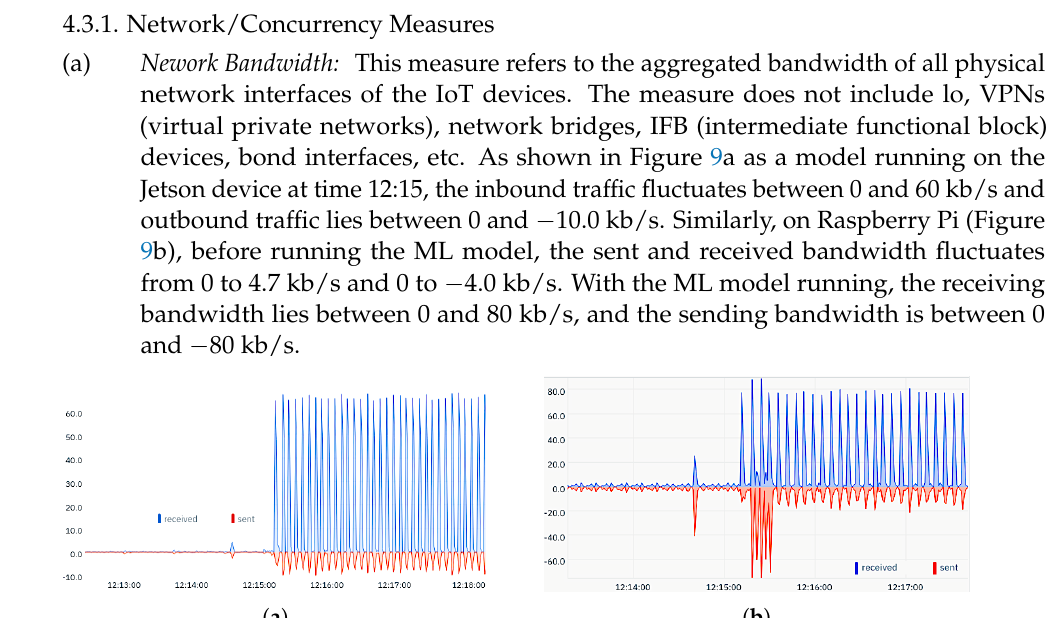
Figure 8. Circuit diagram of the temperature sensing use-case, ( a ) Publisher, and ( b ) Subscriber.